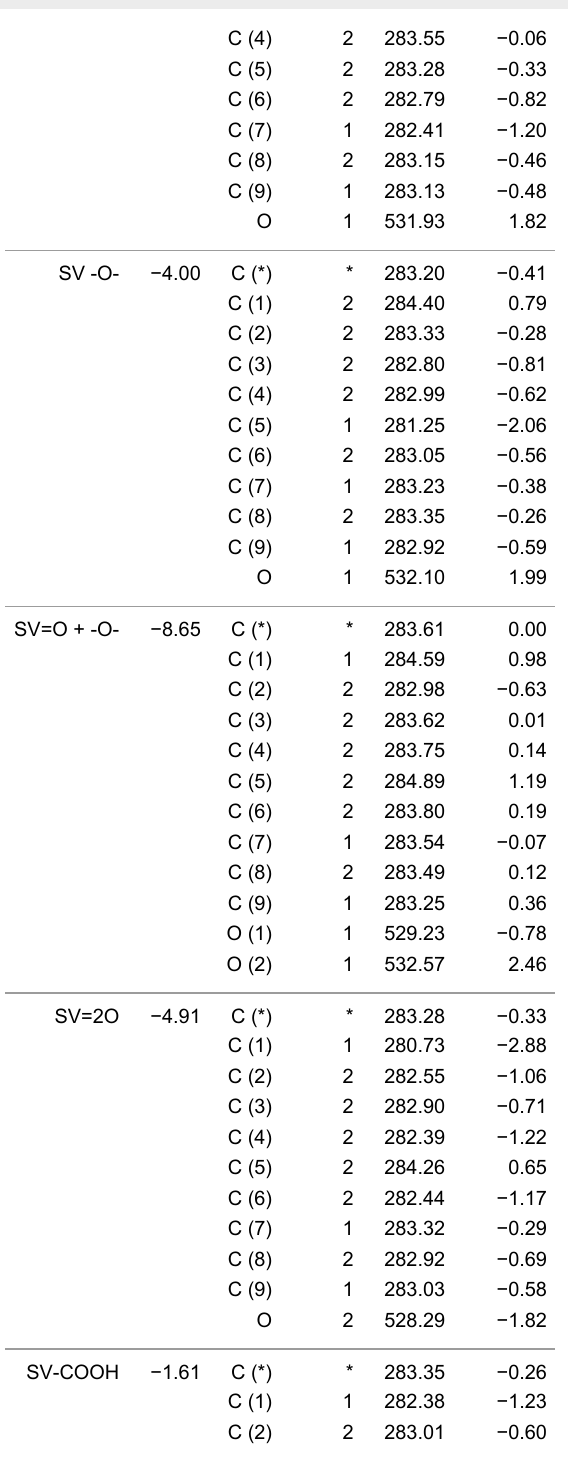
Table 3: Calculation results for the saturated single vacancy struc- tures. The columns show: system identifier; formation energy of the defect; target atom of the calculation (see Figure 3); number of target atoms; calculated 1s binding energy; C 1s BE shift with respect to the calculated C 1s energy of pristine graphene or the O 1s BE shift with respect to the calculated O 1s energy of epoxide/hydroxide functional groups, where applicable.